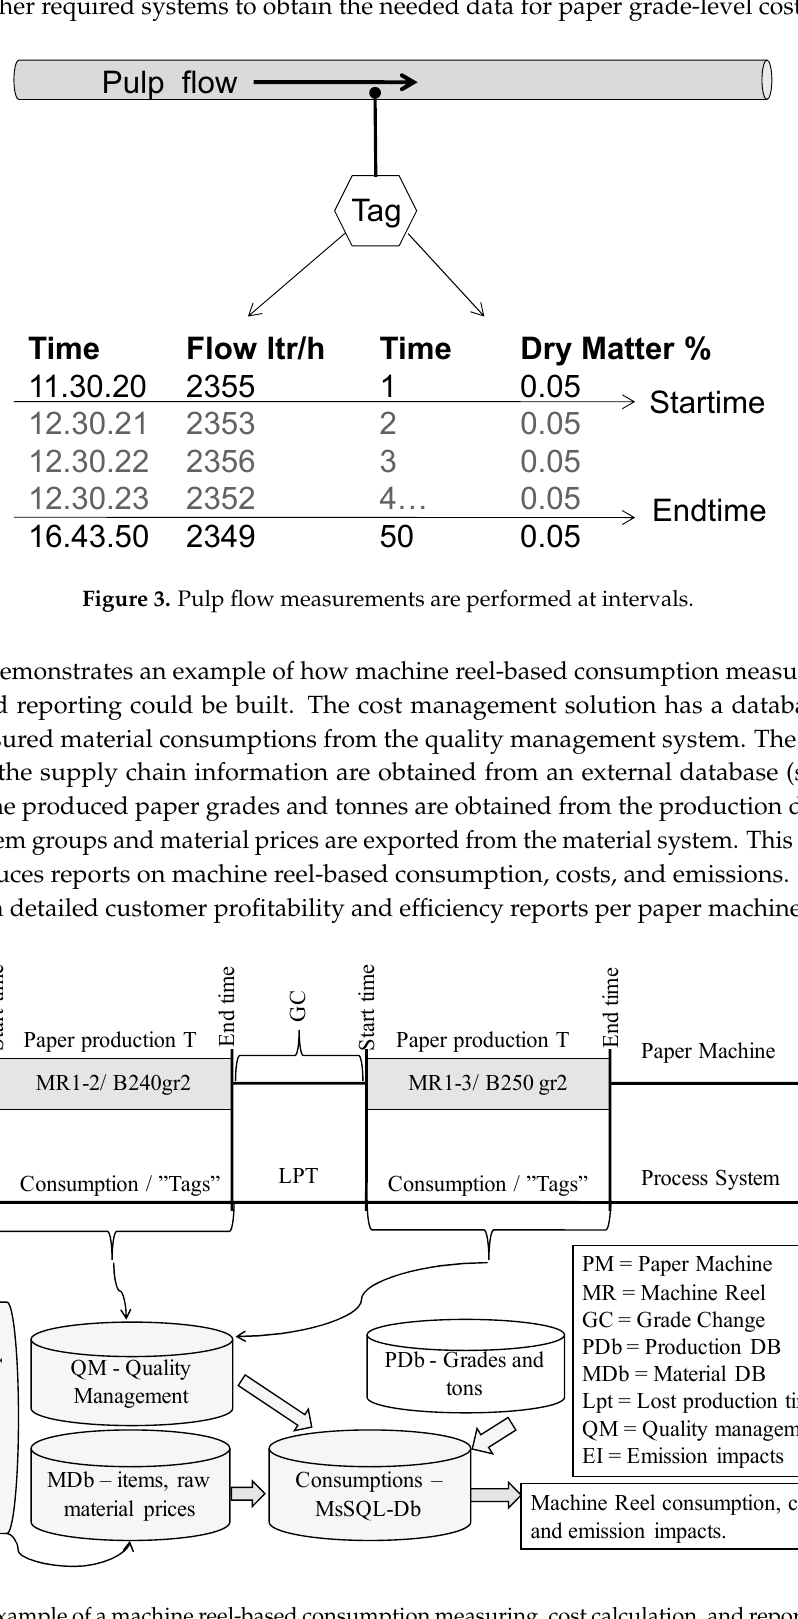
Figure 4. Example of a machine reel-based consumption measuring, cost calculation, and reporting tool.